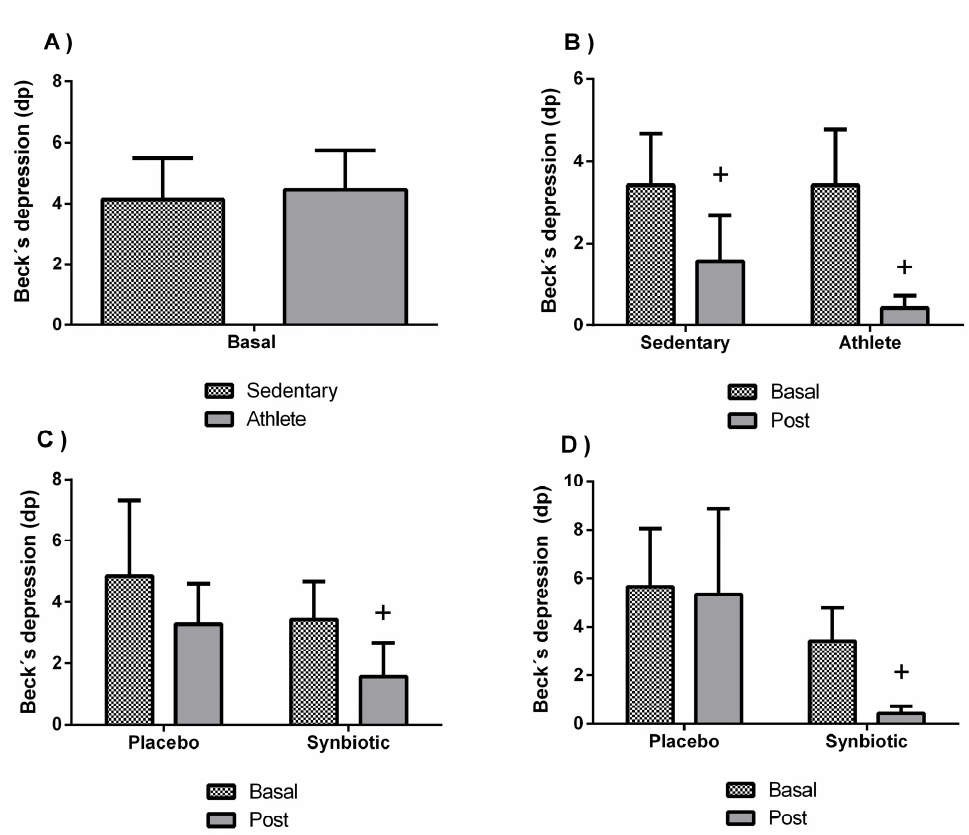
Figure 4. Effect of training and consumption of a synbiotic in this condition on perceived depression levels. ( A ) Perceived depression levels in sedentary men ( n = 14) and athletes ( n = 13); ( B ) Influence of training on the effects of the synbiotic on perceived depression levels ( n = 7 and n = 6 in sedentary and athlete groups, respectively); ( C ) Effect of the consumption of the synbiotic on perceived depression levels in sedentary individuals with respect to placebo ( n = 7) or with synbiotic ( n = 7); ( D ) Effect of the consumption of the synbiotic on perceived depression levels in athlete individuals with placebo ( n = 6) or with synbiotic ( n = 7). The determinations are expressed by the mean ± SD of each of the samples. + p < 0.05 with respect to the baseline.